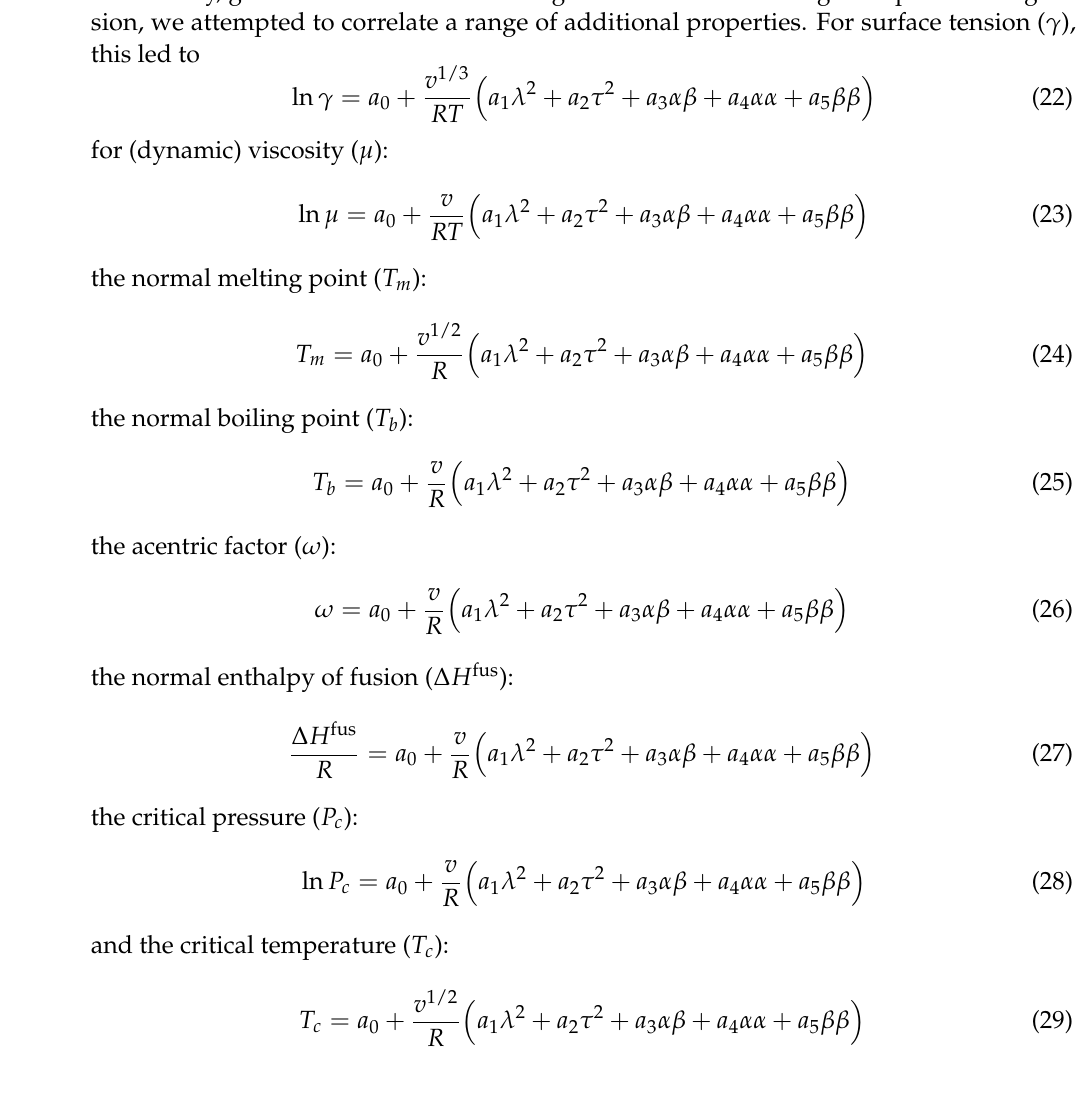
Figure 6. Residual plot of the difference between the reference and calculated solvation free energy ( ∆ G solv , Equation (4)) for organic solutes in water, versus the reference values. ∆ G solv 2,1 kJ/mol. The solid line corresponds to the y = 0 line and is drawn as a reference. Predictions were made for MOSCED with ln P sat computed using the Clausius–Clapeyron equation with a reference 2 temperature of 20 ◦